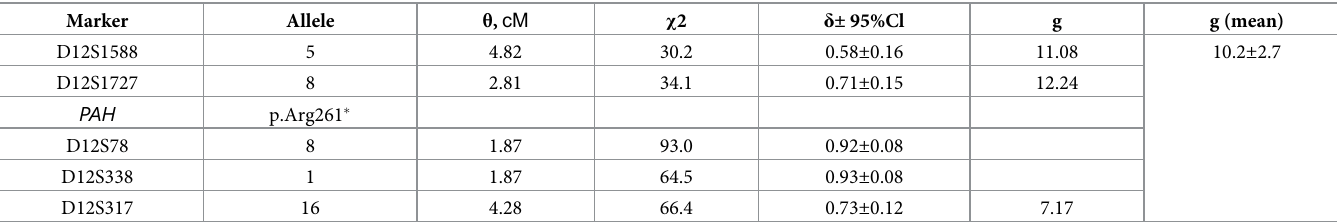
Table 2. Linkage disequilibrium analysis between the p.Arg261 (cid:3) variant in Karachays and microsatellites close to the PAH gene. Marker